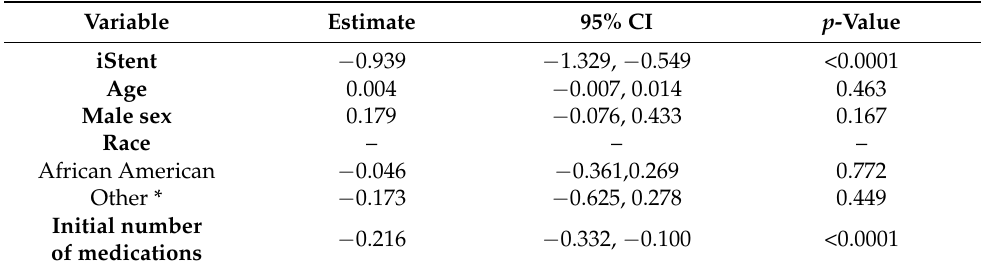
Table 8. Medication reduction complete